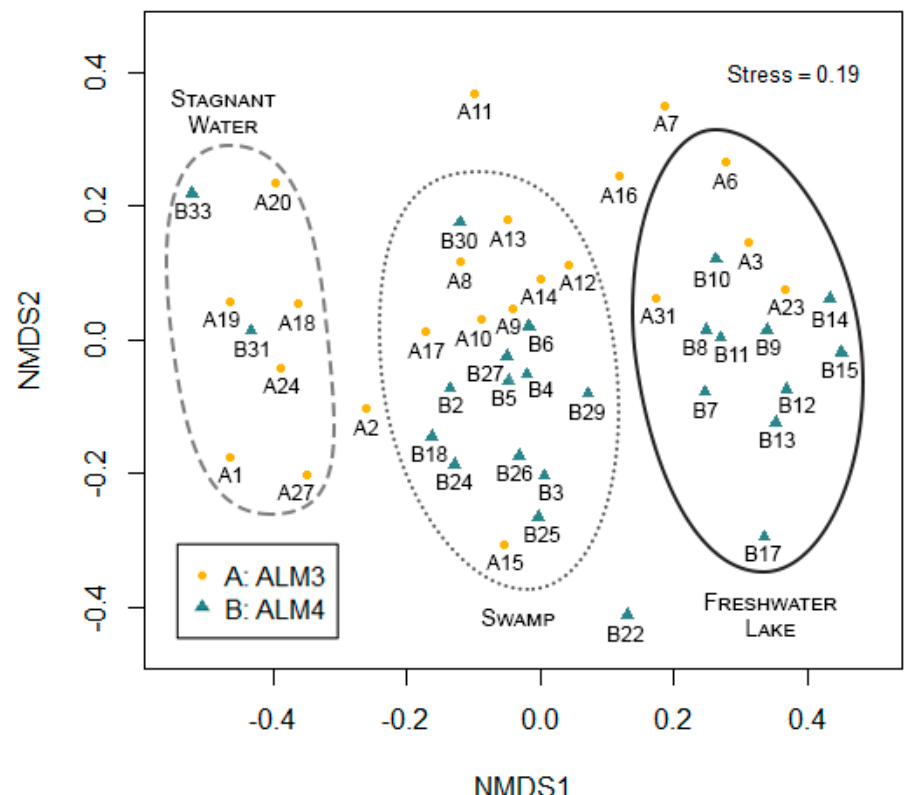
Figure 6. NMDS plot of samples from cores ALM3 and ALM4.